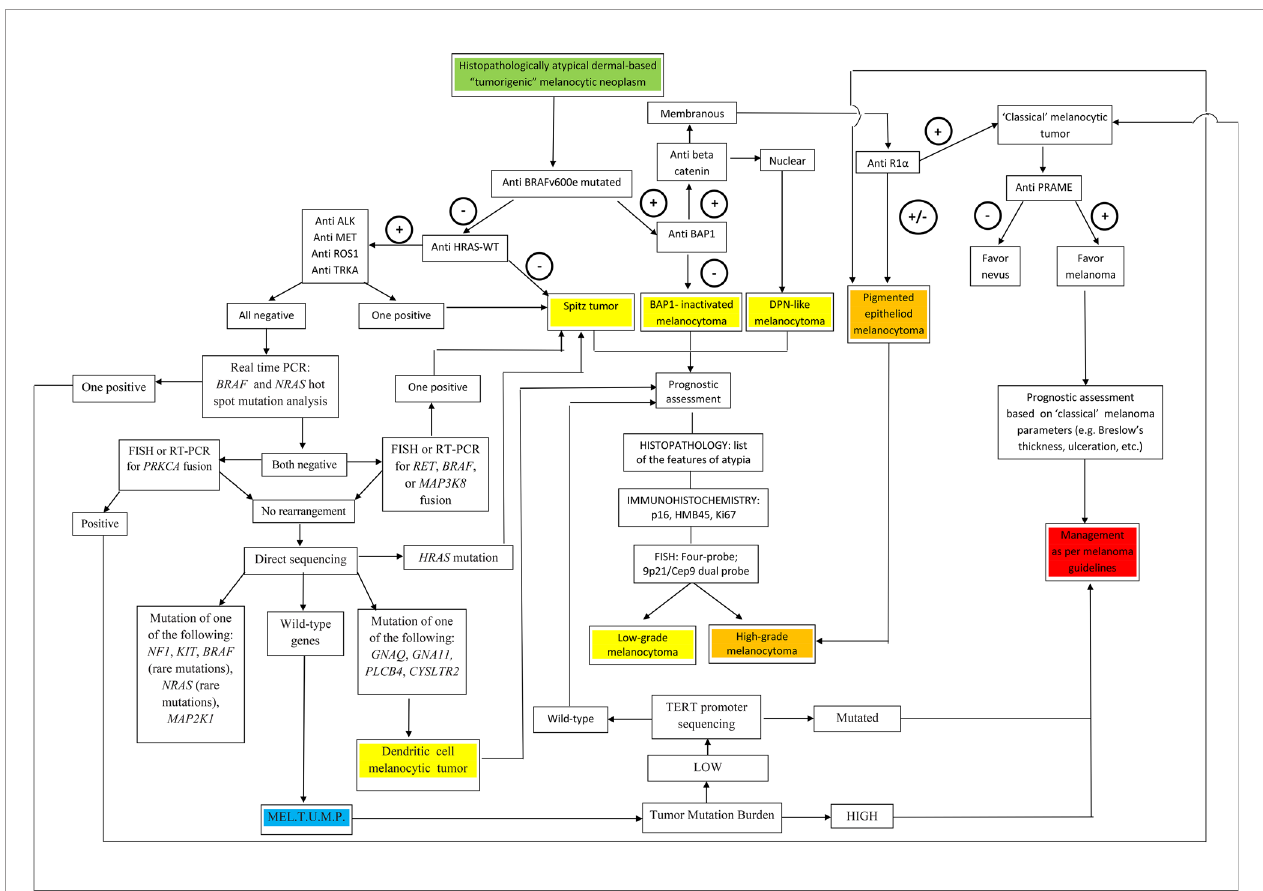
FIGURE 7 | A fl ow chart illustrating a therapy-oriented morphomolecular approach to atypical dermal-based tumorigenic melanocytic neoplasms. Of paramount importance are: i) the distinction between melanocytomas (recognized as such by speci fi c genetic signatures) and melanocytic tumors of uncertain malignant potential (MEL.T.U.M.P.; provisionally de fi ned as tumors with unknown driver mutations); ii) among melanocytomas, the distinction between low-grade and high- grade tumors; iii) among MELTUMP, the distinction between tumors with a low tumor mutation burden and tumors with a a high tumor mutation burden, the latter being best managed as per “ classical ”